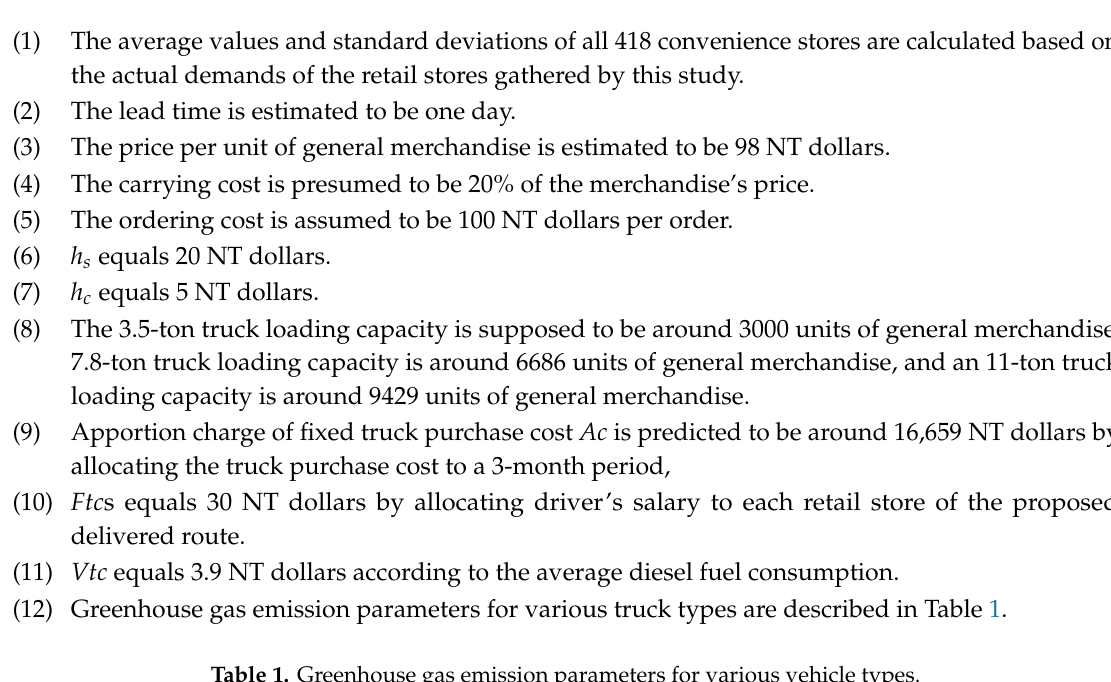
Table 1. Greenhouse gas emission parameters for various vehicle